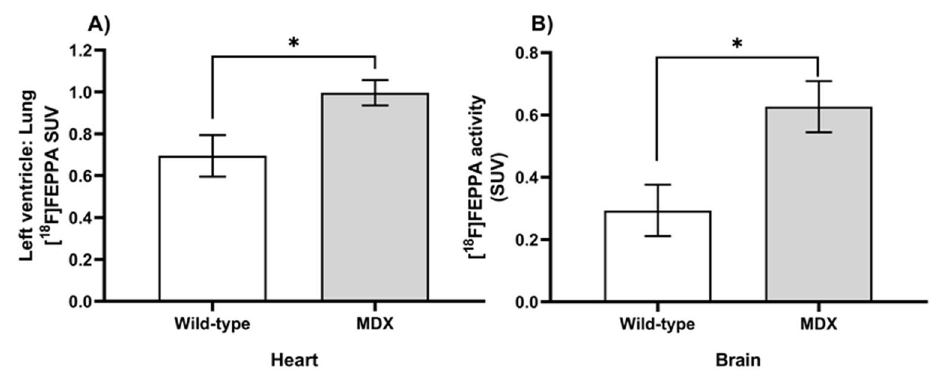
Figure 4. Quantified [ 18 F]FEPPA activity in hearts (A) and brains (B) of age-matched MDX and wild-type mice. Standardized uptake values were generated from PET time-activity curves at 30–60 min using manually drawn regions of interest (ROIs) segmented for the left ventricle, lung, and whole brain ( n = 3–4 slices/mouse/genotype). Significant differences ( p < 0.05; indicated by *) were observed between wild-type (white bars) and mdx:utrn (+/−) mice (gray bars) for both left ventricle-to-lung ratio ( A ) and whole brain ( B ) SUVs using Welch’s two-way t -test. Data are depicted as mean ± standard error. TSPO = (18 kDa) Translocator protein, MDX = dystrophin-deficient mdx:utrn (+/−) mouse model, SUV = standardized uptake values.